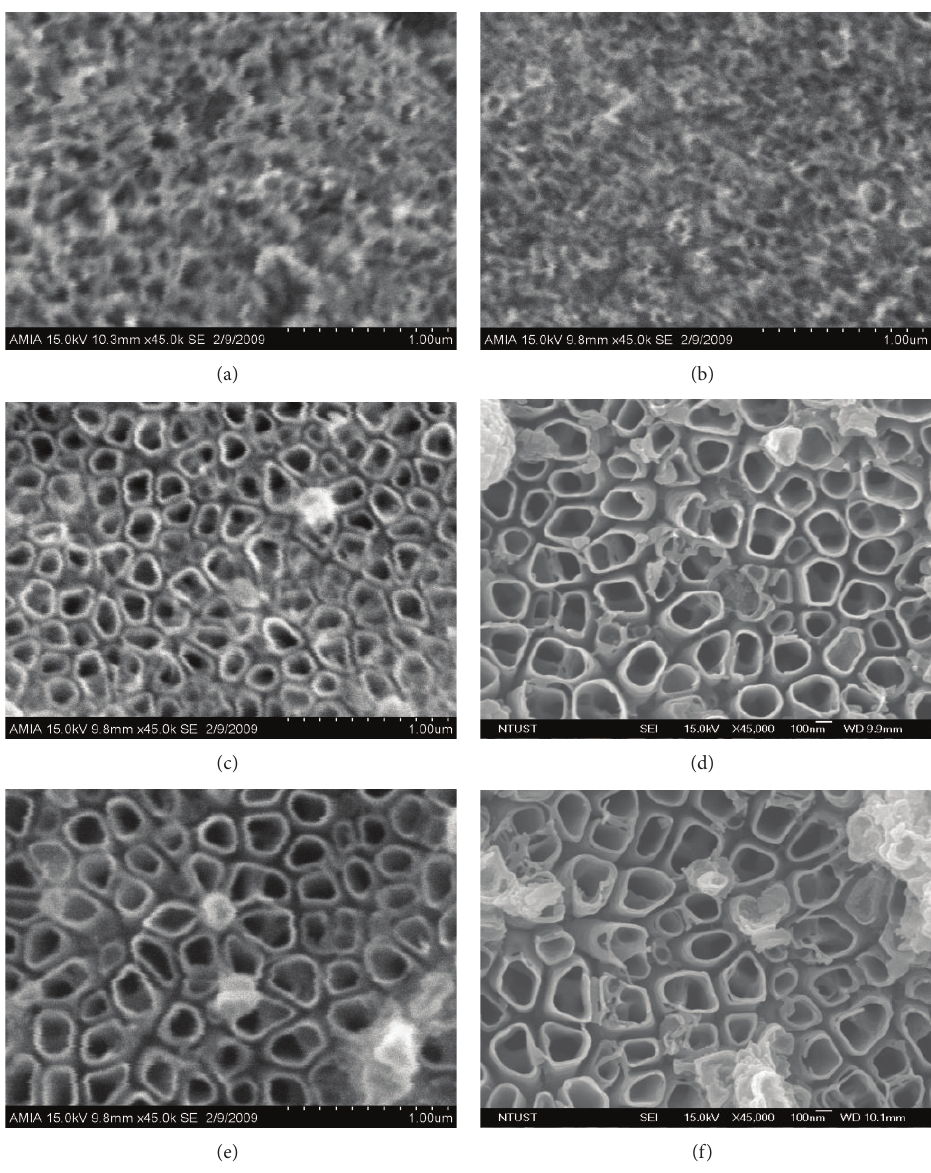
Figure 6: Top view of SEM images of TNT synthesized at different bath temperatures: (a) 10 ∘ C, (b) 20 ∘ C, (c) 40 ∘ C, (d) 50 ∘ C, (e) 60 ∘ C, and (f) 80 ∘